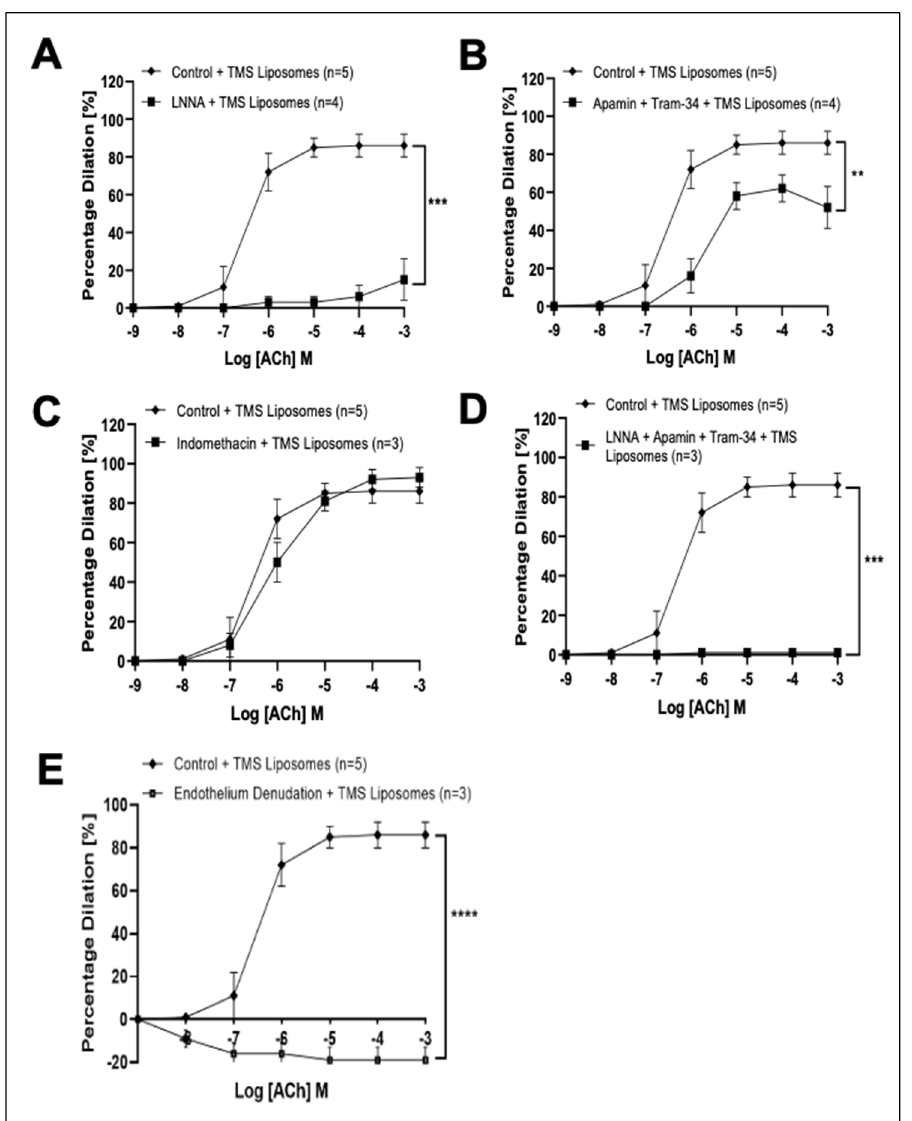
Figure 3. Characterization of dilator responses potentiated by Tetramethoxystilbene (TMS)-loaded liposomes following acute pressure elevation in isolated coronary arteries ex vivo. The influence of N Ω -nitro-L-arginine (LNNA; ( A )), (Apamin and TRAM-34; ( B )), (Indomethacin; ( C )), (L-NNA, Apamin and TRAM-34; ( D )) and (after endothelial denudation; ( E )) on endothelium-dependent acetylcholine (ACh) responses following acute pressure elevation. Control + TMS Liposomes ( n = 5); LNNA + TMS Liposomes ( n = 4); Apamin + Tram-34 + TMS Liposomes ( n = 4); Indomethacin + TMS Liposomes ( n = 3); LNNA + Apamin + Tram-34 + TMS Liposomes ( n = 3); Endothelium Denudation + TMS Liposomes ( n = 3). The area under the curve for two groups were compared using Two-way ANOVA followed by Tukey’s multiple comparisons post-test. Data are presented as mean ± SEM. ** p < 0.01, *** p < 0.001, **** p < 0.0001.